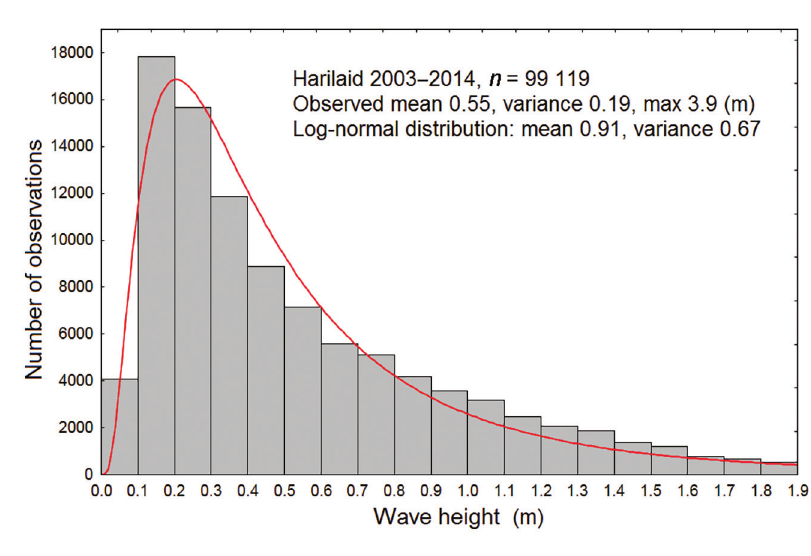
Fig. 3. Empirical distribution function of hindcast wave heights at Harilaid together with a theoretical dis- tribution curve. While short-term distribution of different single wave heights can be described using Rayleigh distribution, the long-term bulk data usually satisfactorily follow either log-normal or Weibull dis-